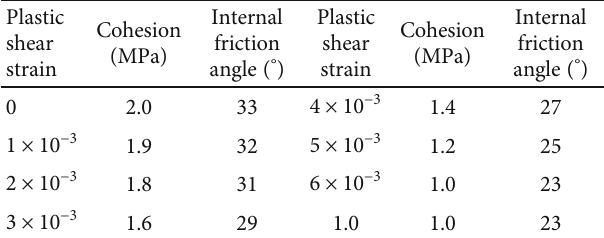
Table 3: Strain softening parameters of sandy mudstone and coal. Plastic